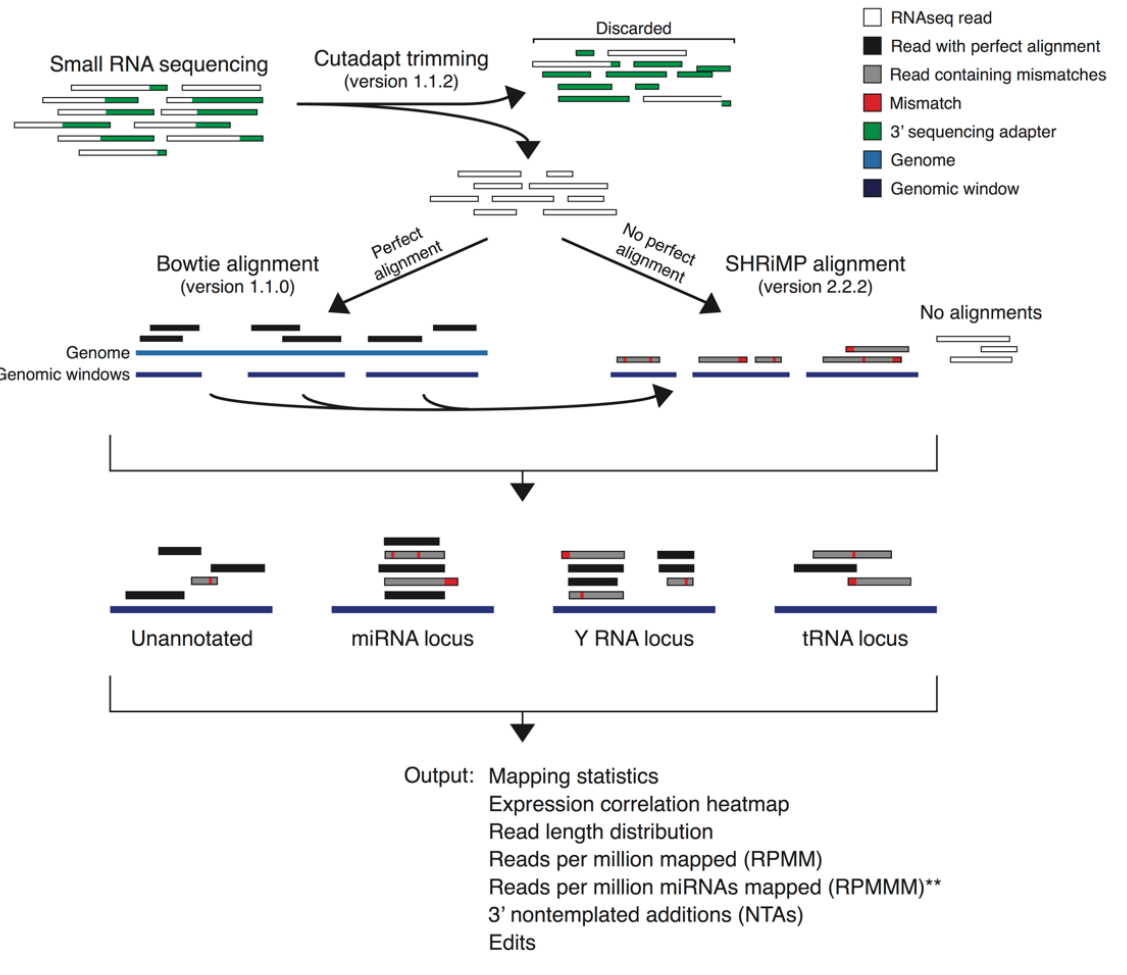
Figure 1: Overview of miRquant 2.0. Major steps of the miRquant 2.0 workflow are shown. Cutadapt is used for trimming partial or full adapter sequences from the 3’-end of small RNA sequencing reads. Those reads that do not have a specified length of adapter sequence at the 3’- end, or that entirely consist of adapter sequences, are discarded. Bowtie and SHRiMP are used for the two-tier mapping process. Unaligned reads after the SHRiMP step are discarded. Annotation is provided for miRNAs, tRNA-derived RNAs (tDRs), and Y-RNA derived RNAs (yDRs). All other mapped loci are grouped into the unannotated category. Normalized expression levels are provided as reads per million mapped (RPMM), and as reads per million mapped to miRNAs (RPMMM) for